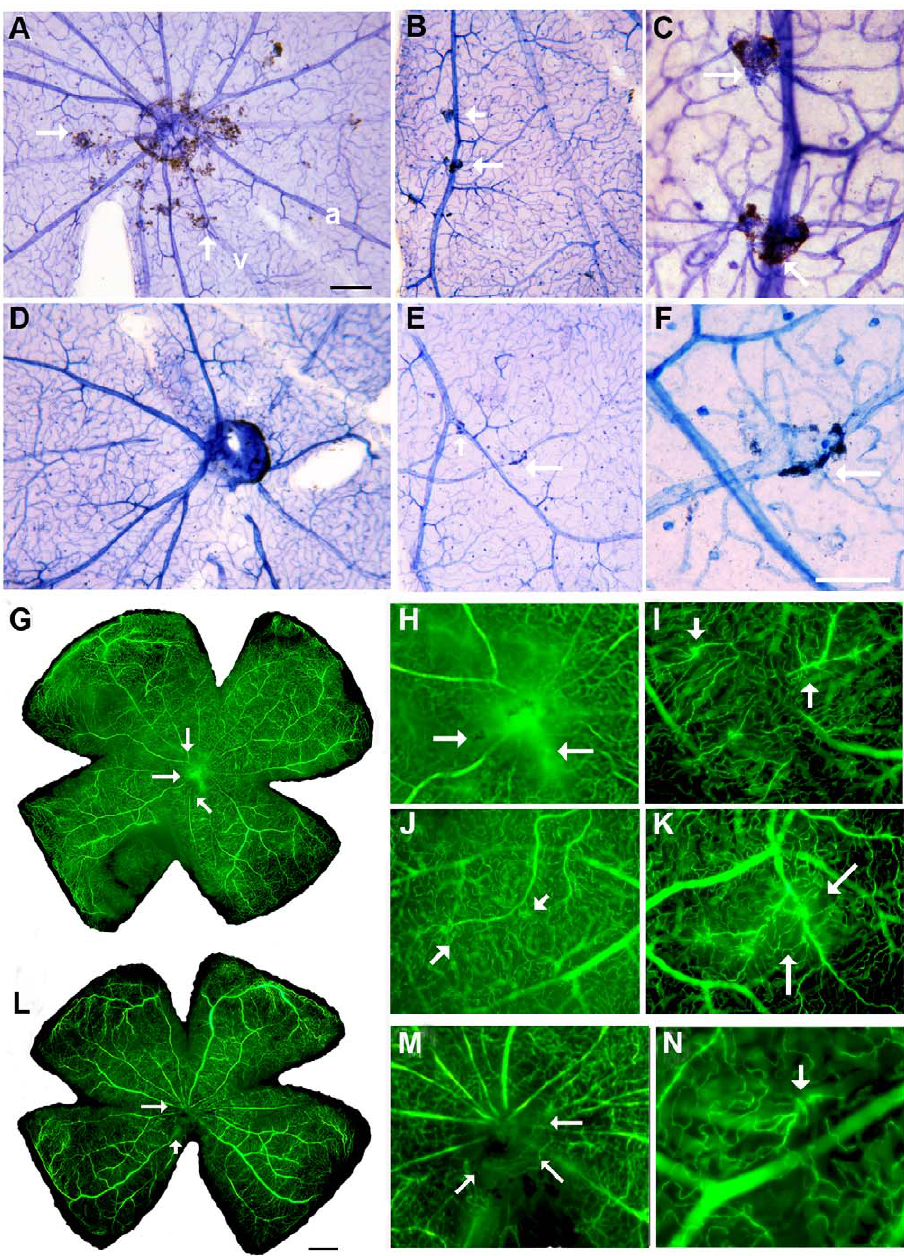
Figure 3. Vascular protection. A–F: Retinal whole mount was stained with NADPH-diaphorase: A. typical vascular pathology in the eye at P90 in untreated RCS rat: vascular complexes (abnormal vessels associated with RPE cells) were mainly located around the optic nerve disc (arrows) and spread peripheral with age. B. vascular complexes in the middle to peripheral retina (arrows). C. high power image showing vascular complexes (arrows) from B. D. RCS retina treated with MSCs at P90: the vascular complexes were dramatically reduced around the optic nerve disc. E. two vascular complexes (arrows) in the middle field of the retina. F. high power image from E showing vascular complexes (arrow). G–L. animal was perfused with FITC-dextran, whole mount was prepared: G. typical vascular leakage, mainly around the optic disc in untreated eye at P90. H–K. high power images from G showing vascular leakage (arrows in H) and abnormal vessels (arrows in I–K). L. MSC treated retina, the vascular leakage around the optic nerve disc was greatly reduced. M&N. high power images from L showing much reduced leakage (arrows in M) and small abnormal vessels (arrow in N) (Scale bars equal 250 m m for A, D, G &L; 100 m m for F). doi:10.1371/journal.pone.0009200.g003 RCS control retina, cone photoreceptors degenerated with a close to the injection site and/or correlated with donor cell distribution, and thus there is no noticeable protection at sites disorganized profile. It would appear that stem cells exert their distant from the grafted cells. effect over the whole retina when administered systemically. In comparison, subretinal delivery of cells including bone marrow The vascular protection bestowed by MSCs is partly mediated derived cells [43,44,45,46] usually results in rod and cone rescue